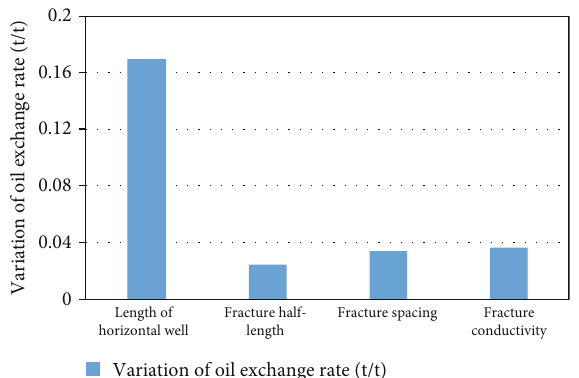
Figure 20: Variation distribution of the oil exchange rate with horizontal well hu ff -n-pu ff 2